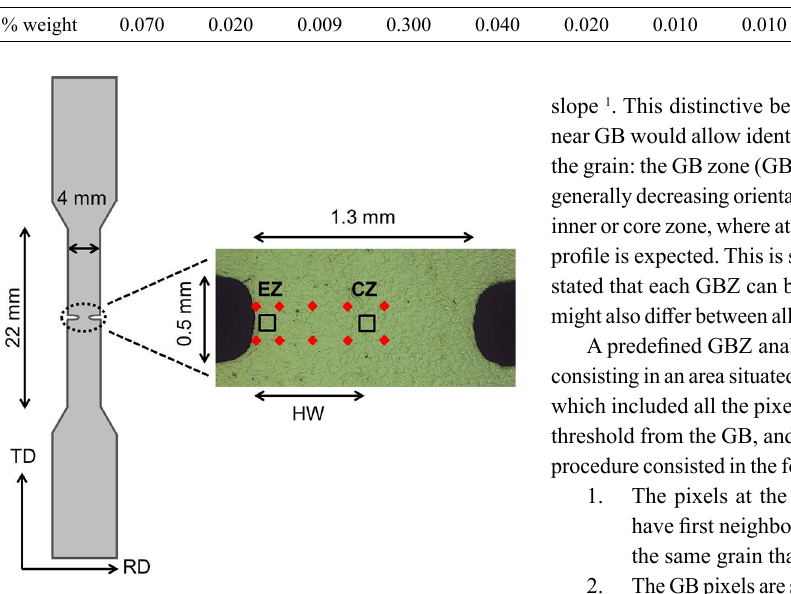
Table 1. Chemical composition of the AKDQ steel sheet used (excluding surface covering) (± 0.001). Element